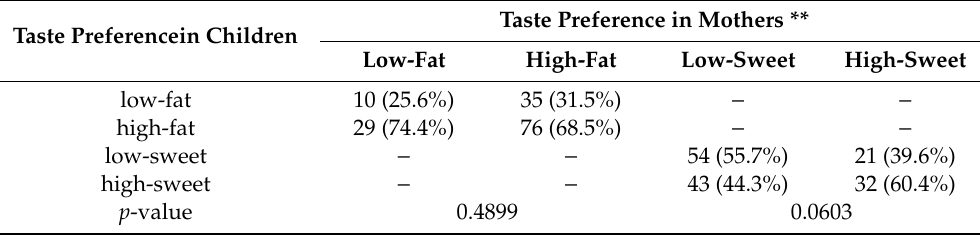
Table 2. Relationship between mothers’ and children’s taste preferences.